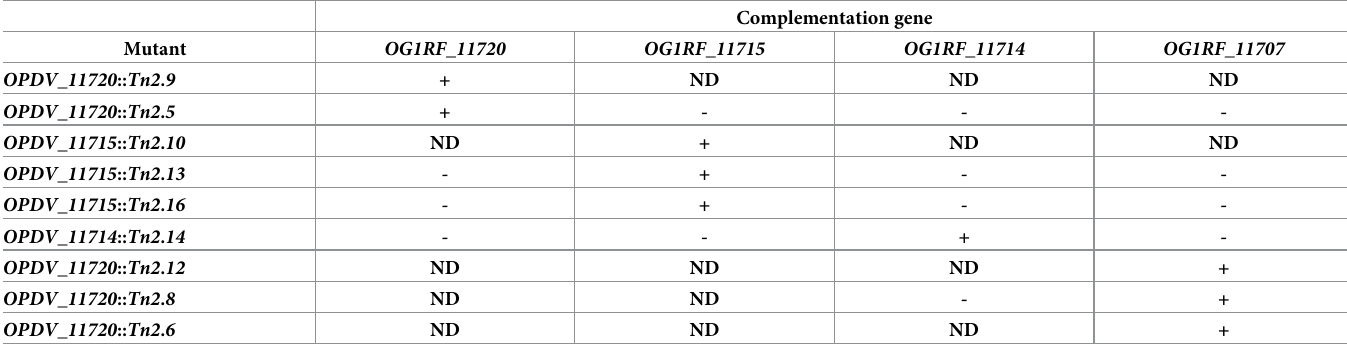
Table 2. Complementation of epa transposon